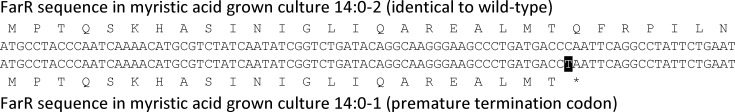
Mutations identified in N. gonorrhoeae grown with sub-lethal myristic acid.The SNP in myristic acid grown culture 14:0–1 is present at the 70th nucleotide into farR (black highlight) and results in the formation of a premature stop codon after 23 amino acids (*). The full length FarR is 146 amino acids.